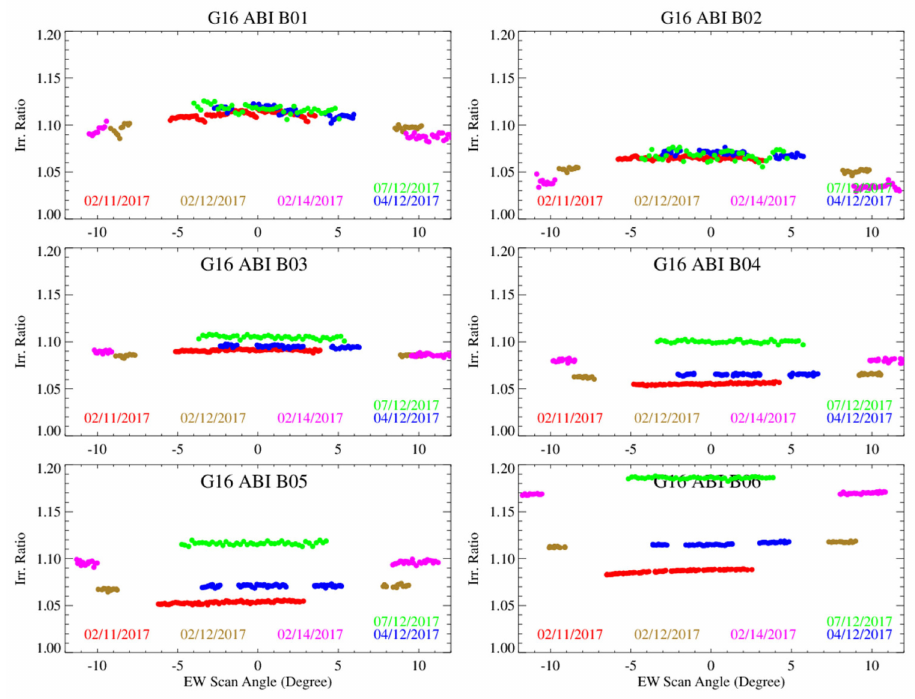
Figure 6. Lunar irradiance ratio versus the EW scan angles for the G16 VNIR